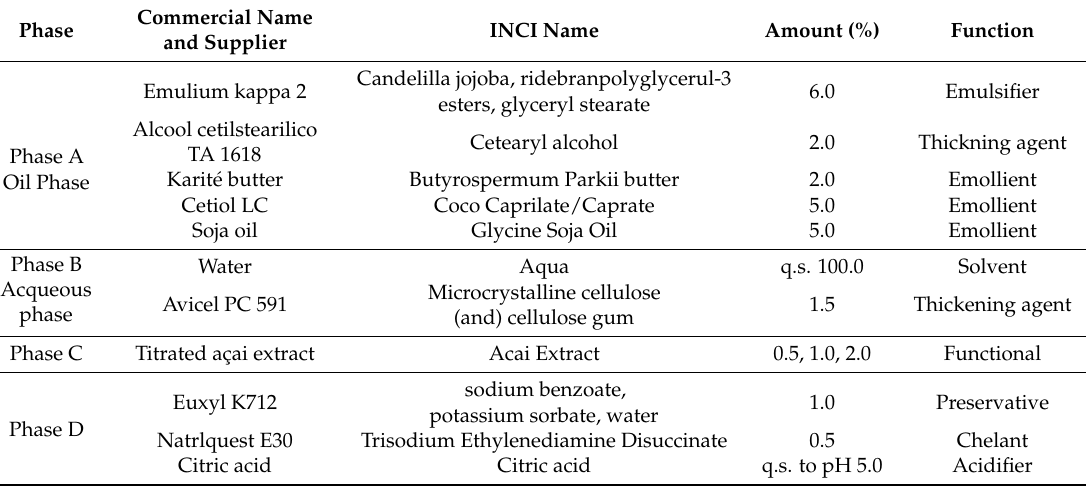
Table 1. Formulation of the O/W emulsion based on açai